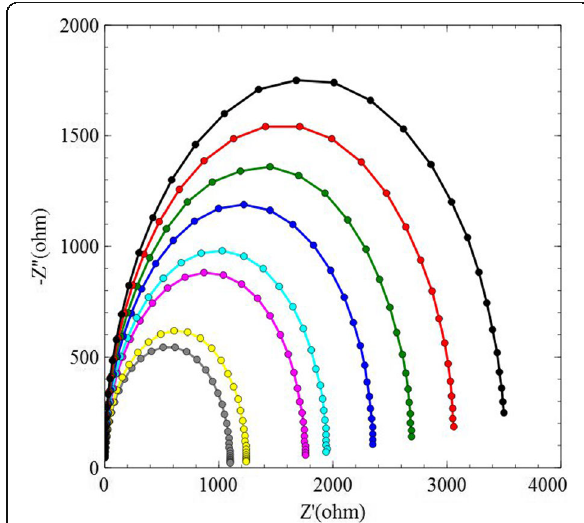
Fig. 2 Nyquist plots of pure water from 25.0 °C ( black outer curve ) to 60.0 °C ( gray inner curve )